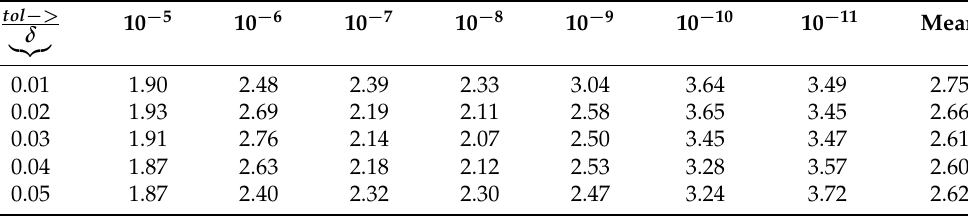
Table 5. Efficiency measures ratios of DLMP6(5) vs. NEW6(5) for perturbed Kepler in [ 0,10 π ]